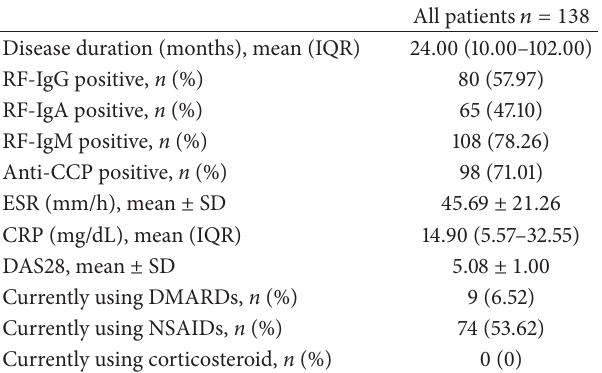
Table 2: Disease-related factors in RA